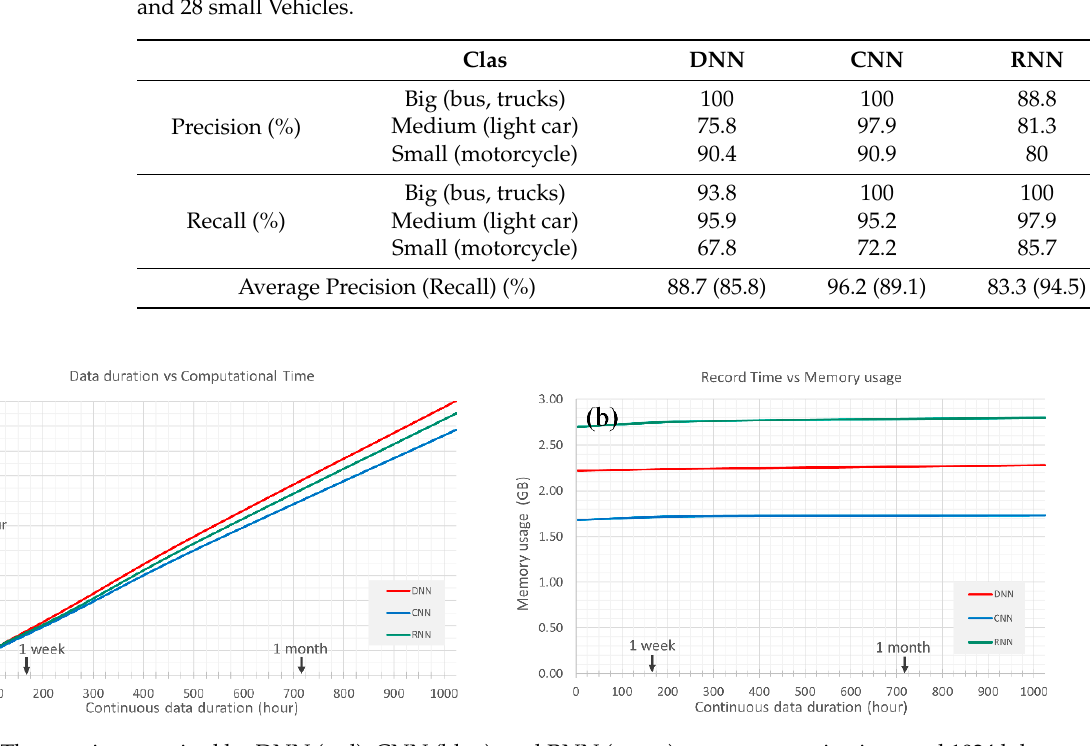
Table 4. Precision and recall of networks on a 15 min data record, including 16 large, 49 medium,